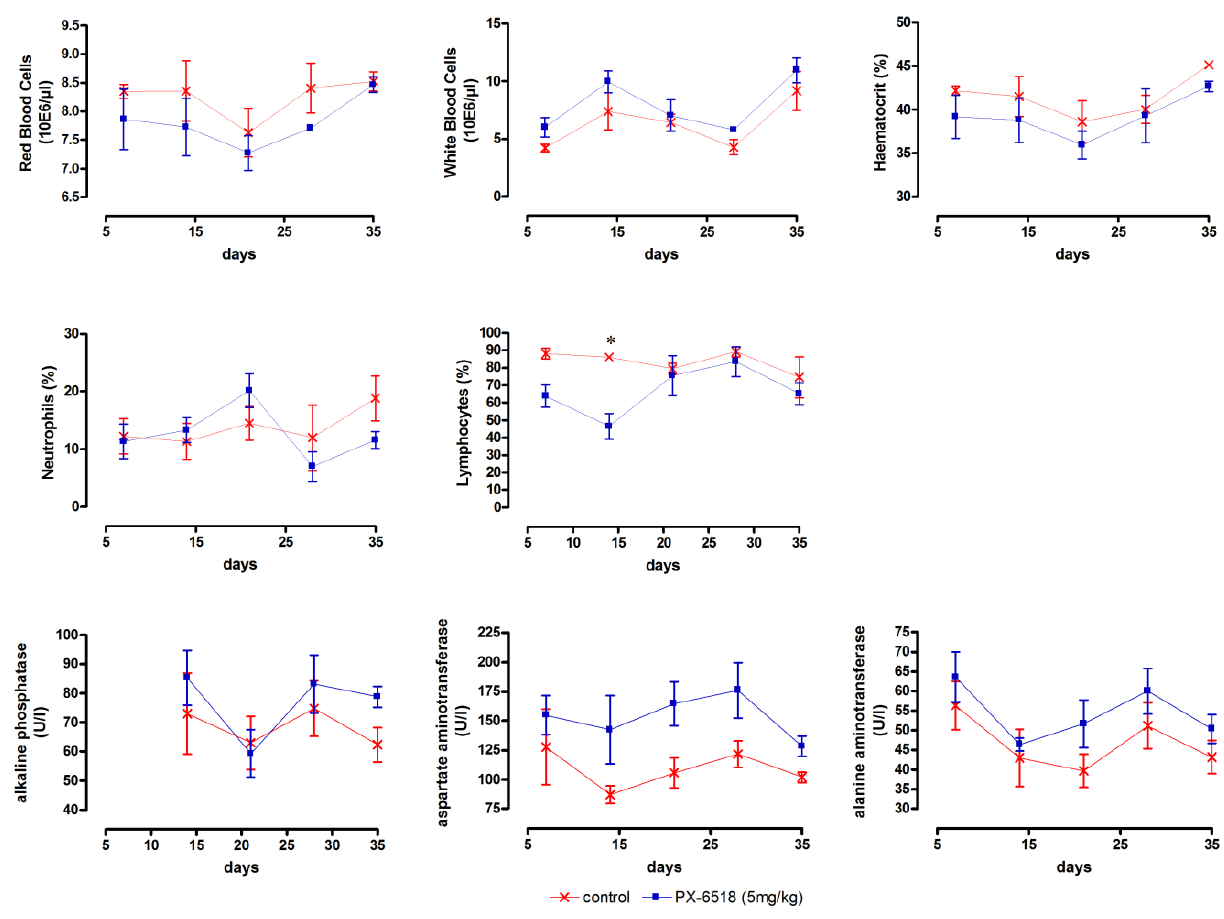
Figure 2. Monitoring of target toxicity parameters (red blood cells, white blood cells, haematocrit, neutrophils, lymphocytes, alkaline phosphatase, aspartate aminotransferase and alanine aminotransferase) in mice after a single SC dose at 5 mg/kg (results for 1 and 2.5 mg/kg did not differ from vehicle-treated control and are not shown). (n = 3 for each time point) * p < 0.05, ** p < 0.01 and *** p < 0.001 (two-way ANOVA with Bonferroni post-hoc )